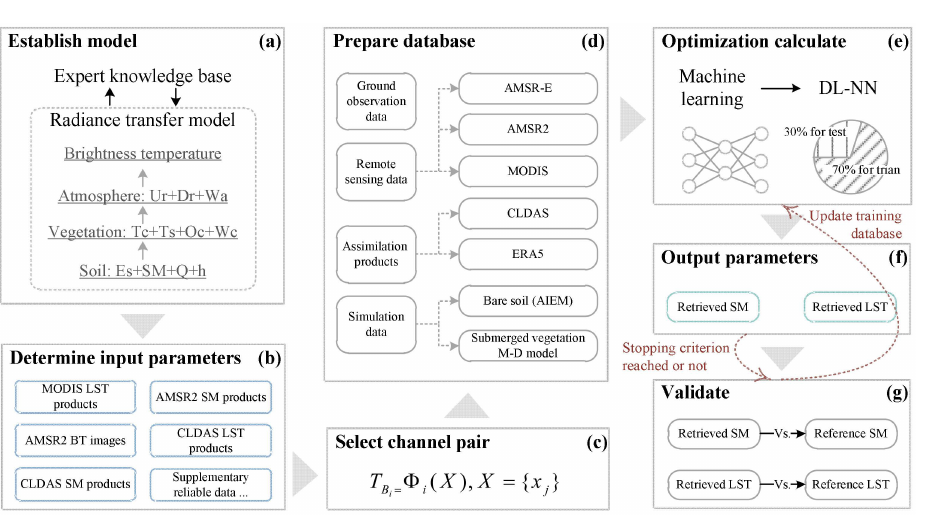
Figure 1. The proposed MDK-CR method consists of two parts: geophysical logical reasoning based on the RTE (Steps ( a – d )), and an iterative optimization algorithm using a deep learning neural network (DL-NN) (Steps ( e – g )). In Step ( a ), The brightness temperature at satellite includes contributions from the soil (emissivity (Es), soil moisture (SM), roughness parameters (Q & h)), vegetation (vegetation canopy temperature (Tc), soil temperatures (Ts), vegetation opacity (Oc) and vegetation water content (Wc)), and atmosphere (upwelling atmospheric radiance (Ur), downwelling atmospheric radiance (Dr), atmosphere water vapor (Wa)). Models and characteristics of land surface microwave emission have been studied extensively; Q and h are roughness parameters. In Step ( c ), (cid:110) (cid:111) x j the model function Φ i ( X ) relates the parameters of the soil-vegetation-atmosphere medium to the brightness temperature observations T B at channel i i